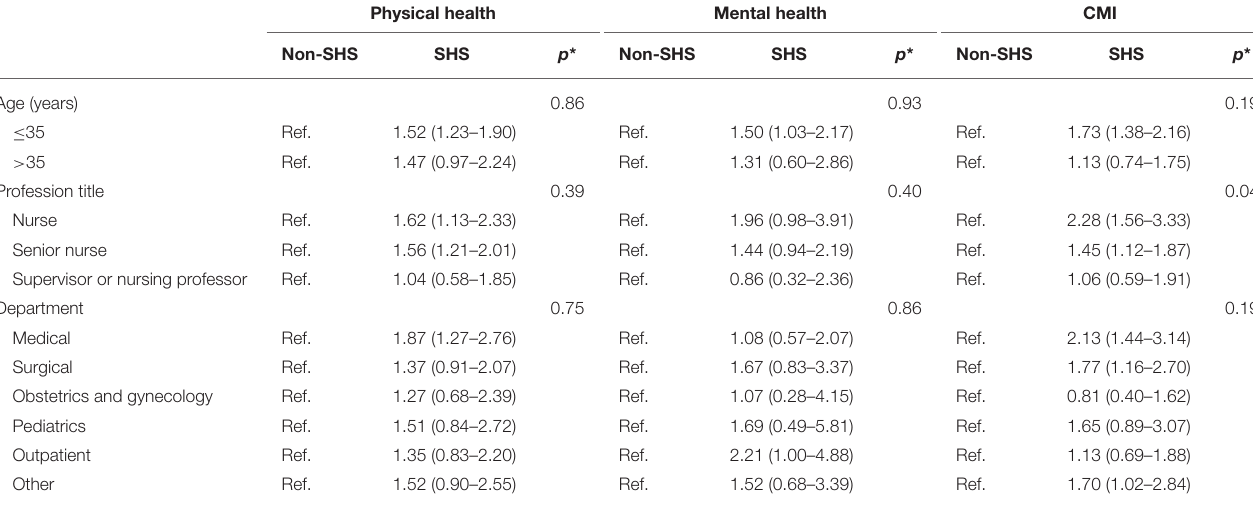
TABLE 4 | Subgroup and interaction